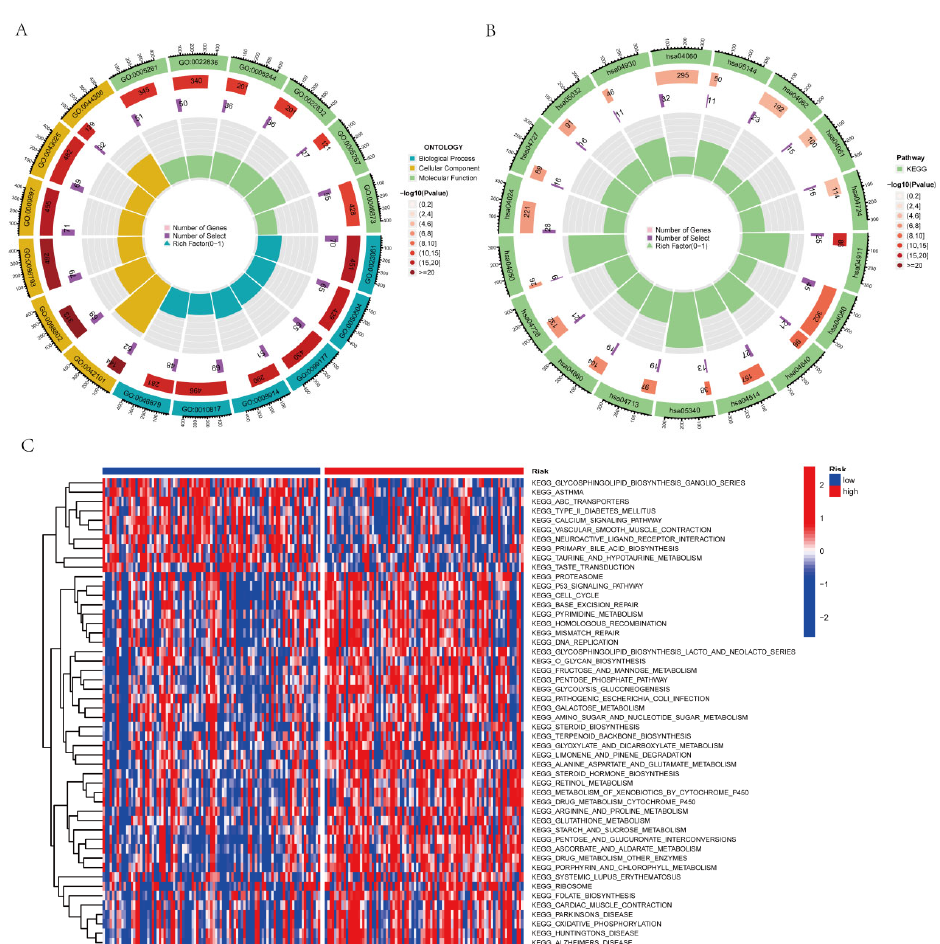
Figure 8. The enrichment pathways in various functional assessments. ( A ) Investigation of the GO enrichment of genes with differential expression. ( B ) The KEGG pathway enrichment investigation of the genes with differential expression ( C ) The GSVA between the high ‐ risk and low ‐ risk cohorts.